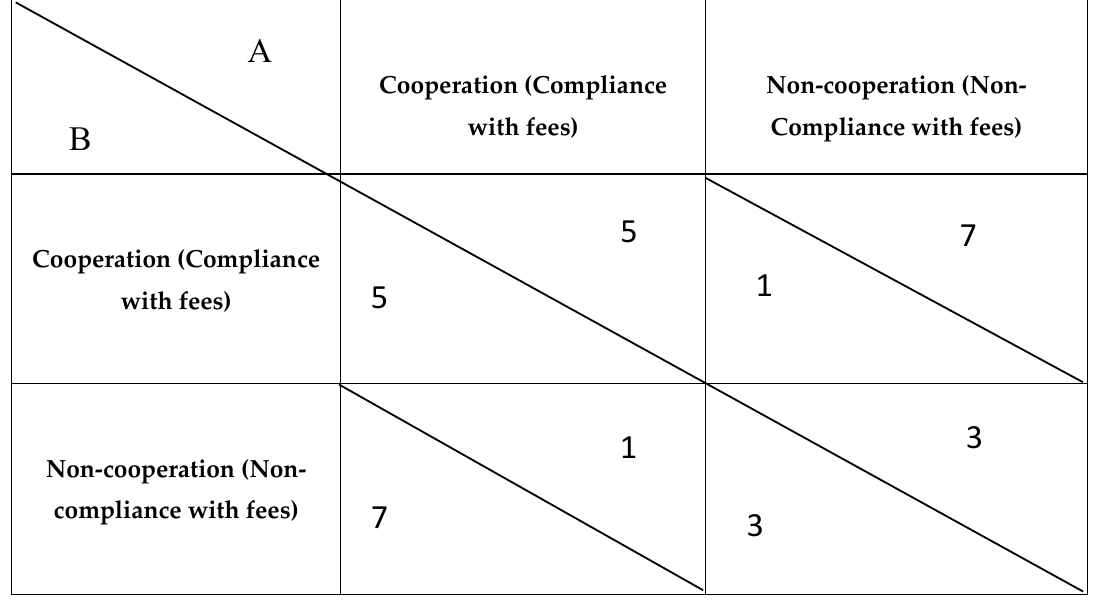
Figure 2. Payoff matrix for paying irrigation fees for two farmers. Figure 2. Payo ff matrix for paying irrigation fees for two